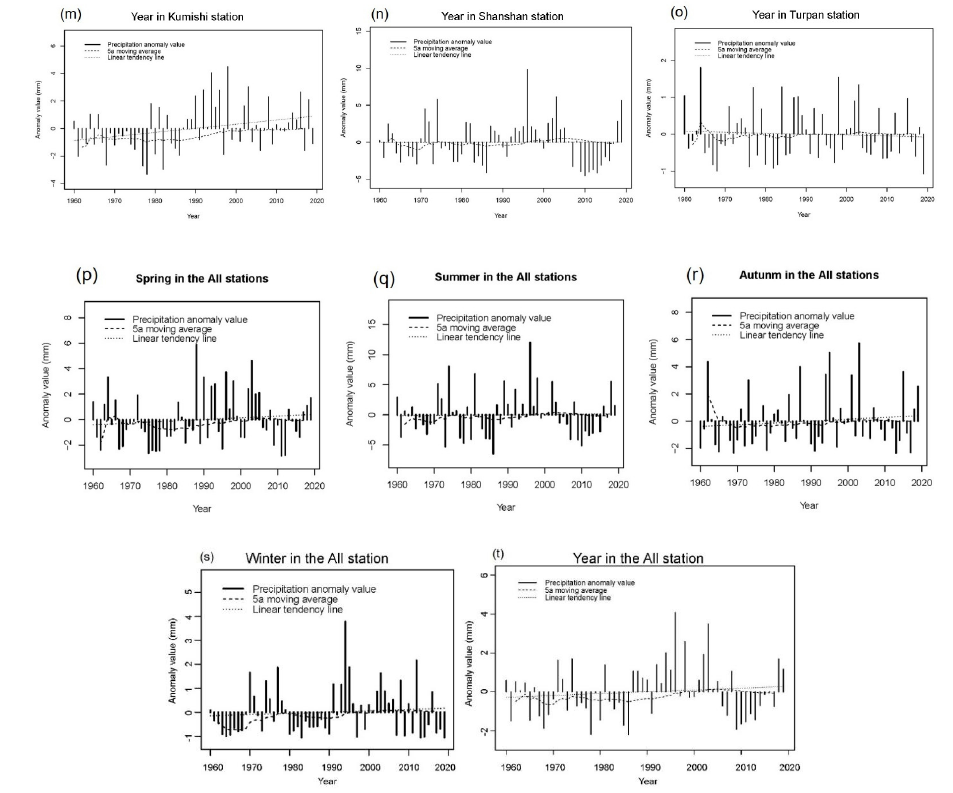
Figure 4. Anomaly value, 5a moving average and linear tendency of the precipitation in the Turpan region. The spring precipitation in the Turpan station had a downward trend at a signi fi cance level of 0.001 (Table 2), which decreased at a rate of − 0.002 mm·(10a) − 1 . The positive trend of summer precipitation at the Kumishi station was detected at a significance level of 0.1 (Table 2), which increased at a rate of 0.048 mm·(10a) − 1 . An upward trend of annual precipitation was discovered for the Turpan region, though spring and summer precipitation at the Turpan station and Shanshan station showed a downward trend. The increasing rate for the Turpan region was 0.009 mm·(10a) − 1 , while the rates for the Kumishi, Turpan and Shanshan stations were 0.03, − 0.003 and 0.001 mm·(10a) − 1 , respectively. This indicates that the increased rate of annual precipitation at the Kumishi station was the greatest among the three stations, followed by the Shanshan station. The seasonal changing trends for the three stations are shown in Table 2. The increasing rate of precipitation at the Kumishi station was the maximum in the spring and summer, then followed by autumn and winter, which was the minimum. The changes in the rate of precipitation at the Turpan station were very small, and the autumn precipitation remained the same. However, the spring, summer and winter precipitation indicated a